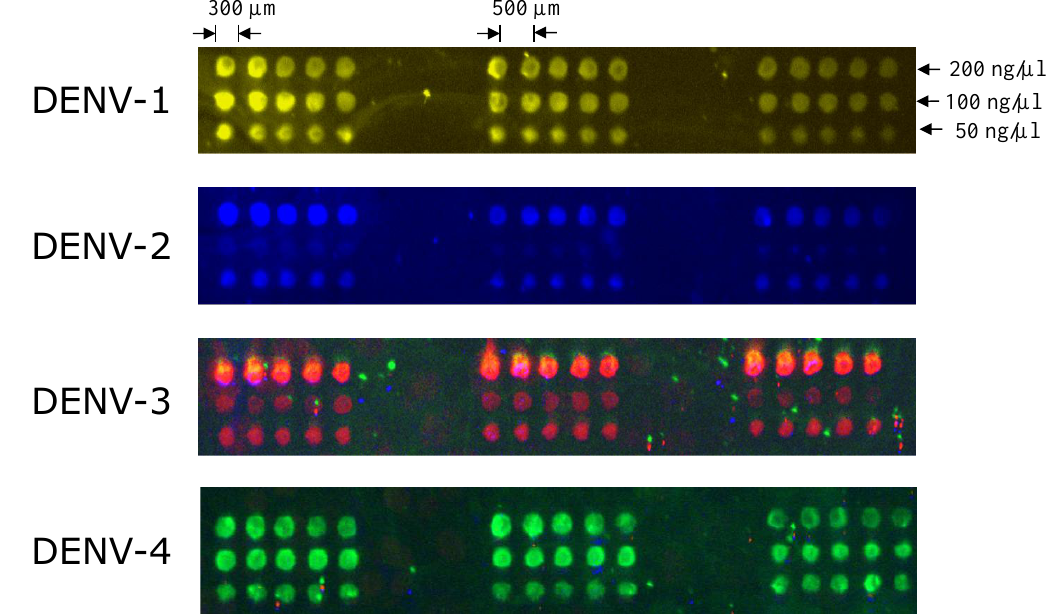
Figure 2. Hybridisation patterns of representative DENV serotypes, indicated on the left side of each array. Vertical lanes represent different RT-PCR product concentrations (50, 100, and 200 ng∙µL −1 , respectively) for each DENV serotype. Specific labelled primers (Texas Red for DENV-1, FAM for DENV-2, CY5 for DENV-3 and Yakima Yellow for DENV-4) were hybridised as described in the Experimental Section and the arrays were spotted in